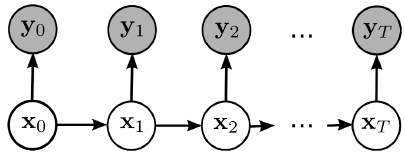
Figure 3. Hidden Markov model